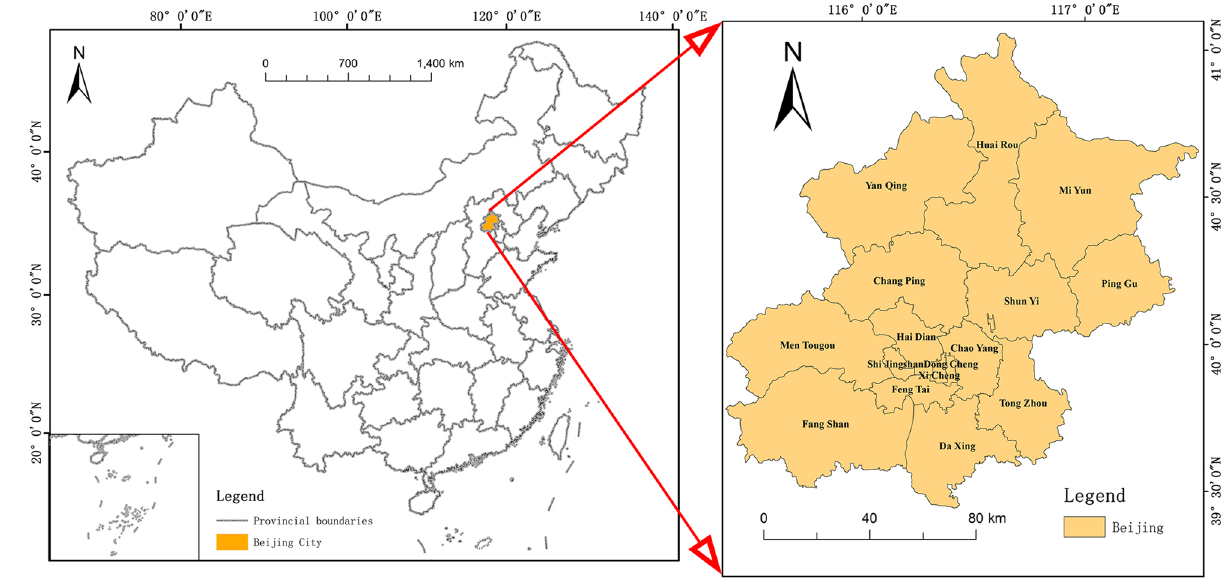
Figure 6. The location of Beijing in China and the administrative zoning map of Beijing. The figure was drawn with ArcGIS sofware version 10.4. (https:// www. esri. com/ en- us/ arcgis/ produ cts/ arcgis- deskt op/ overv iew). The China map data and Beijing boundary data were collected from Resources and Environmental Science and Data Center (http:// www. resdc. cn/).